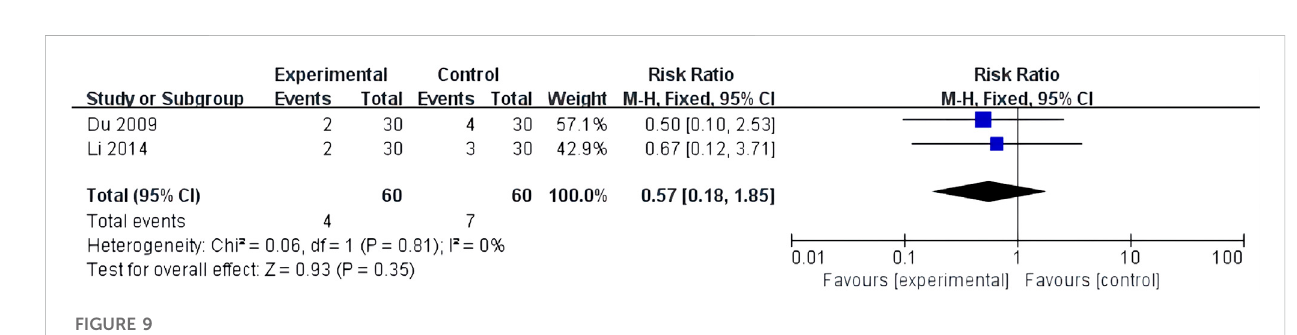
FIGURE 9 Forest plot of sdverse Cardiovascular